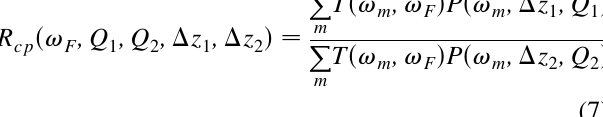
FIG. 7. An example of the transmission characteristic for the filter with 117 GHz central frequency. The theoretical trans- mission curve, and the experimental points are computed and measured by the rms length (cid:14) z into the TM eigenmode. Referring to 0m ; (cid:14) z; Q (cid:6) , and consequently Fig. 3, we point out that P (cid:5) ! m ; Q; (cid:14) z (cid:6) is deter- the integrated detector response D (cid:5) ! F mined by and sensitive to the bunch rms length, whereas the details of the longitudinal distribution are not important.